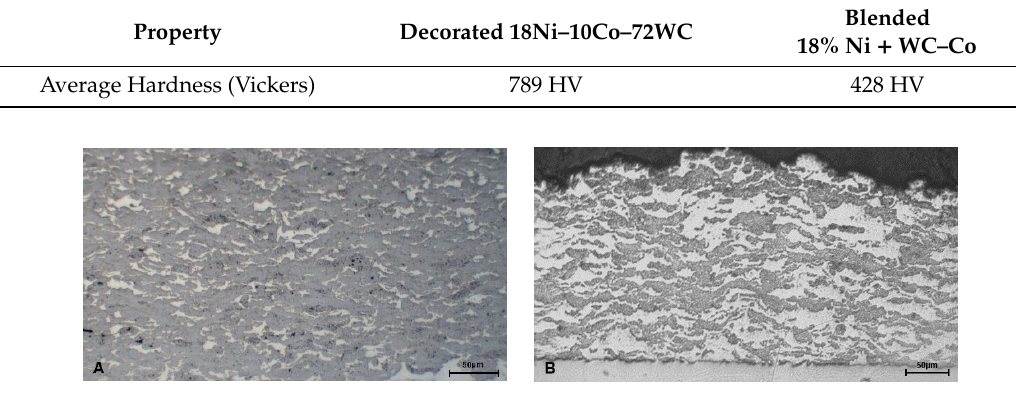
Figure 5. Cross-sections of cold spray deposits: ( A ) decorated 18Ni – 10Co – 72WC; ( B ) blended 18Ni – 10Co – 72WC. Table 5. Comparison of coating hardness for tungsten carbide (WC)-based powders manufactured using different